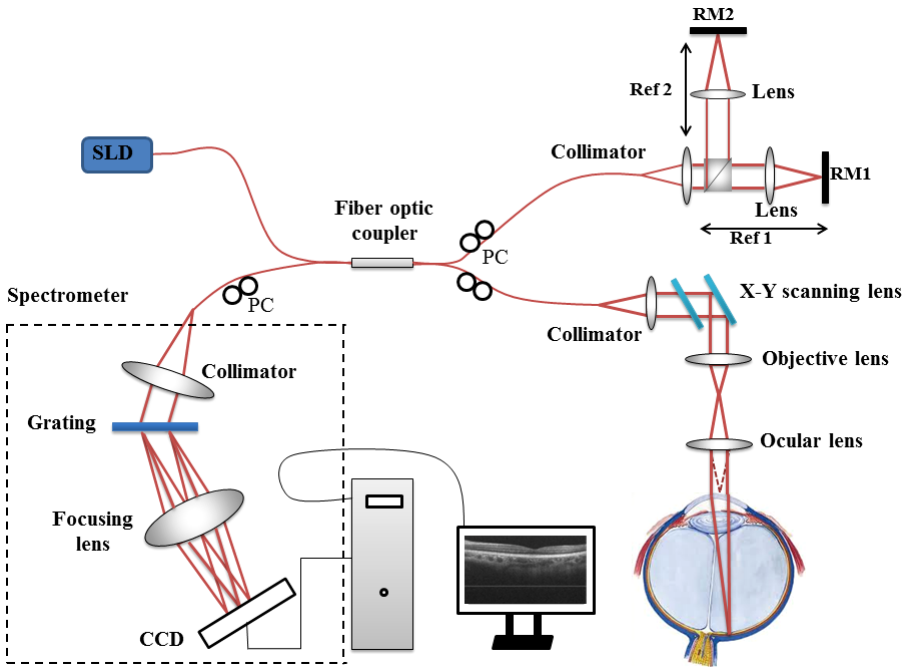
Fig. 1. Schematic of the ultrahigh-speed SDOCT system setup. SLD: 1050 nm superluminescent diode; PC: polarization